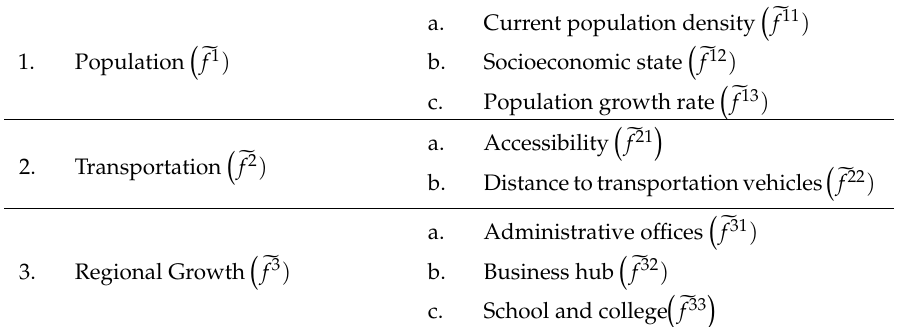
Table 2. Representing the factors and